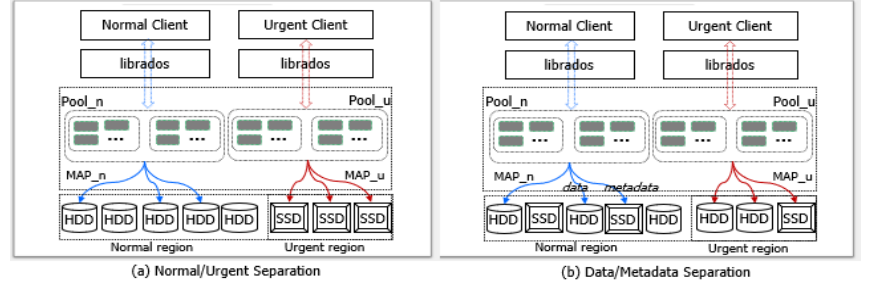
Figure 8. Two use cases for heterogeneous storage devices: separating normal and urgent clients and separating data and